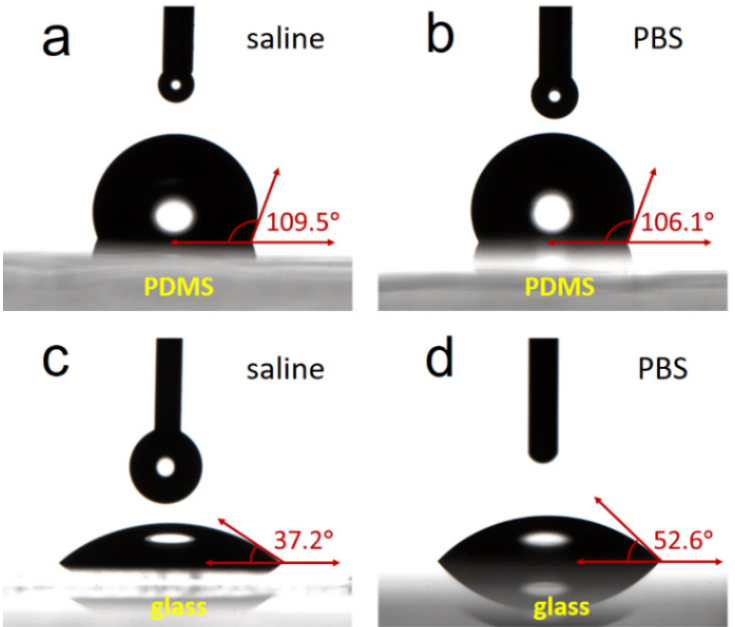
Figure 3. Contact angle measurements for PDMS and glass cover slide. ( a ) Saline on PDMS. ( b ) PBS on PDMS. ( c ) Saline on glass slide. ( d ) PBS on glass slide.